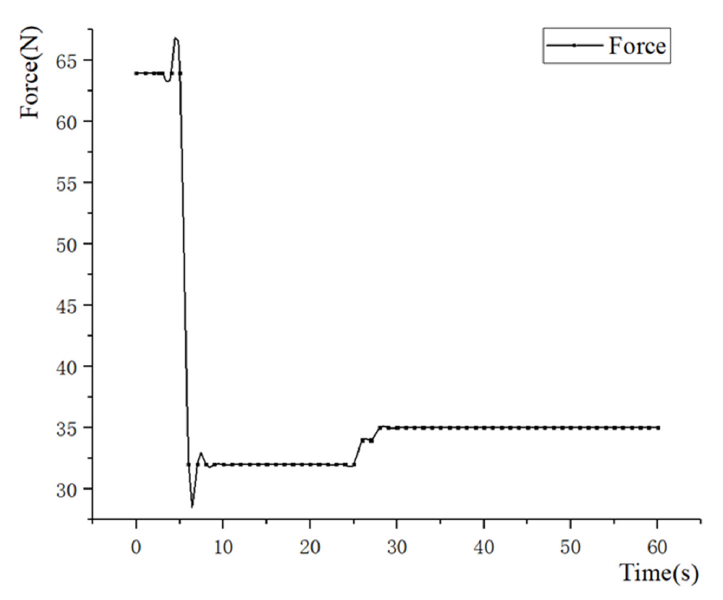
Figure 11. The resistance of the pushing process.